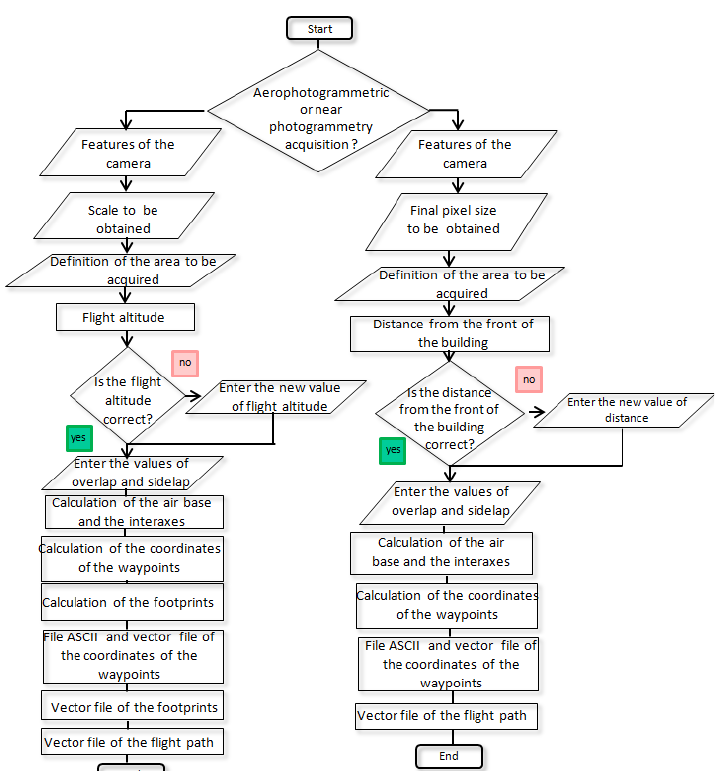
Figure 3. Flow chart of the software